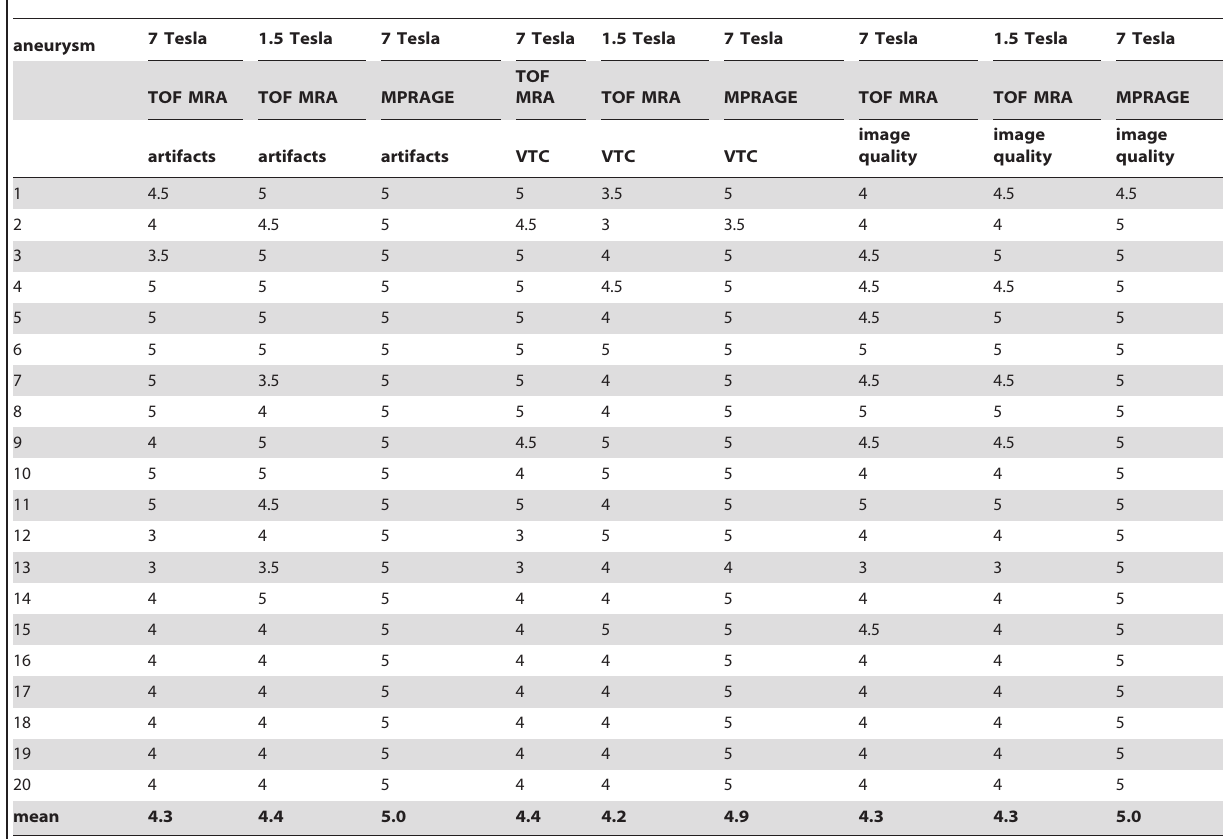
Table 5. Ratings for artifacts. vessel-tissue contrast (VTC) and overall image quality (mean ratings from both readers).